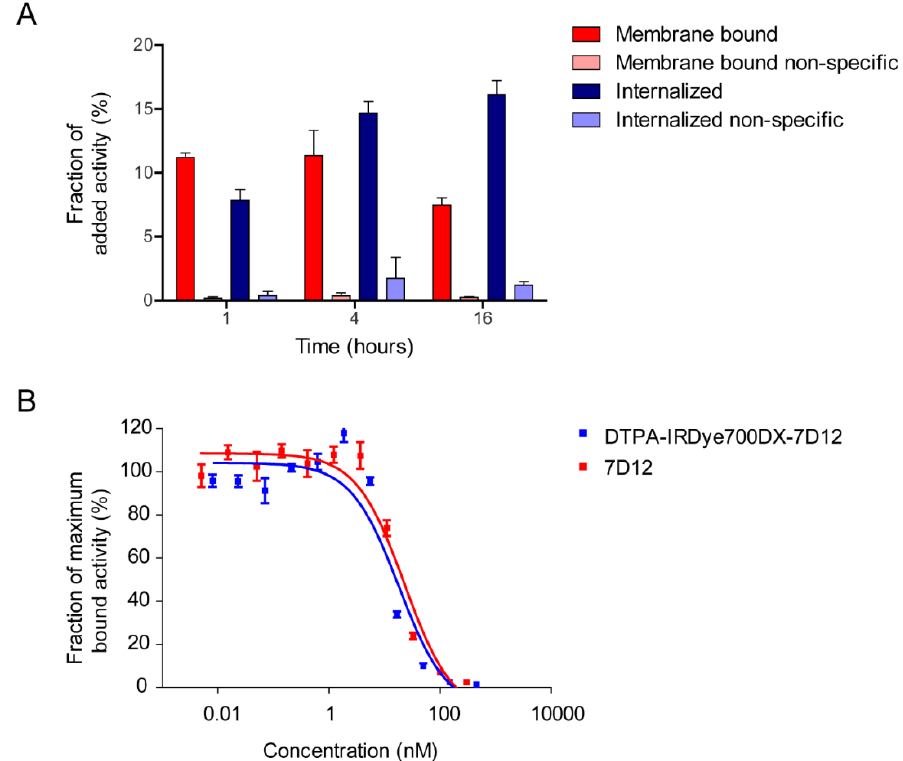
Figure 4. ( A ) Bound and internalized fractions of [ 111 In]In-DTPA-IRDye700DX-7D12 after 1, 4 and 16 h of incubation at 37 °C, in absence or presence of an excess of unlabeled native 7D12. ( B ) Competition of cell associated [ 111 In]In-DTPA-IRDye700DX-7D12 by increasing concentrations of native 7D12 or unlabeled DTPA-IRDye700DX-7D12.